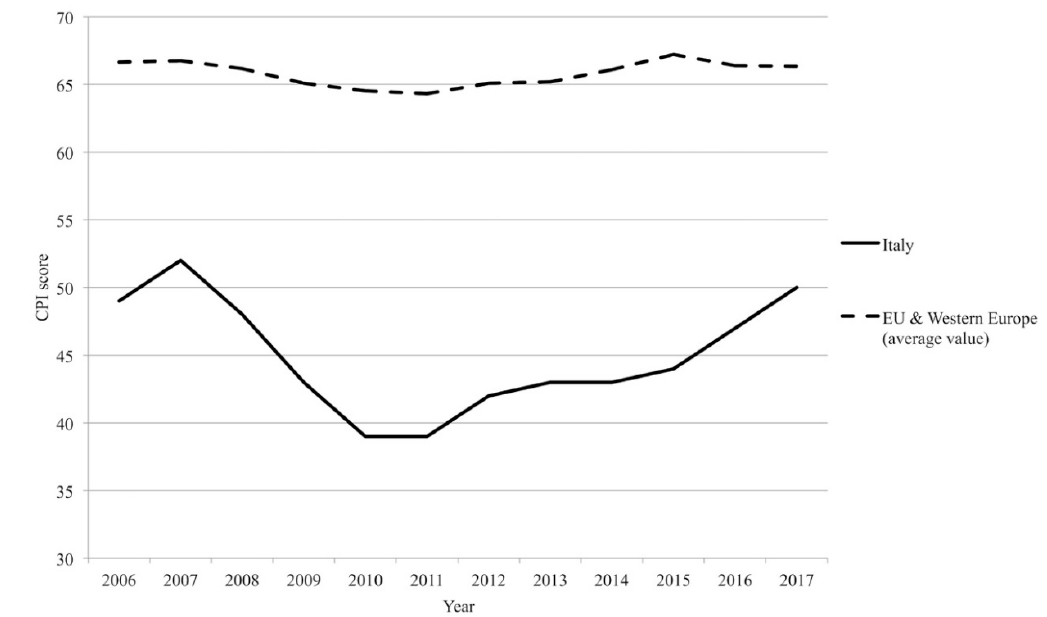
Figure 1. Corruption Perception Index trend in Italy and in the EU and Western Europe (average value) for the period between 2006 and 2017. Source: Transparency International (2017).